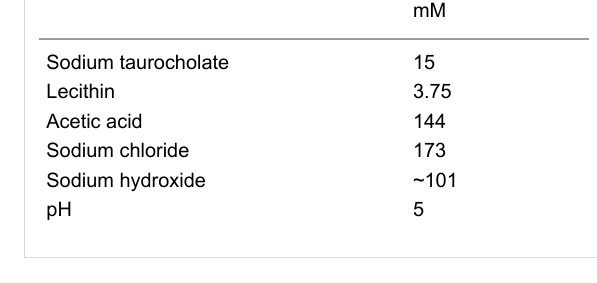
Table 1: Composition of the Fed-State Simulated Intestinal Fluid